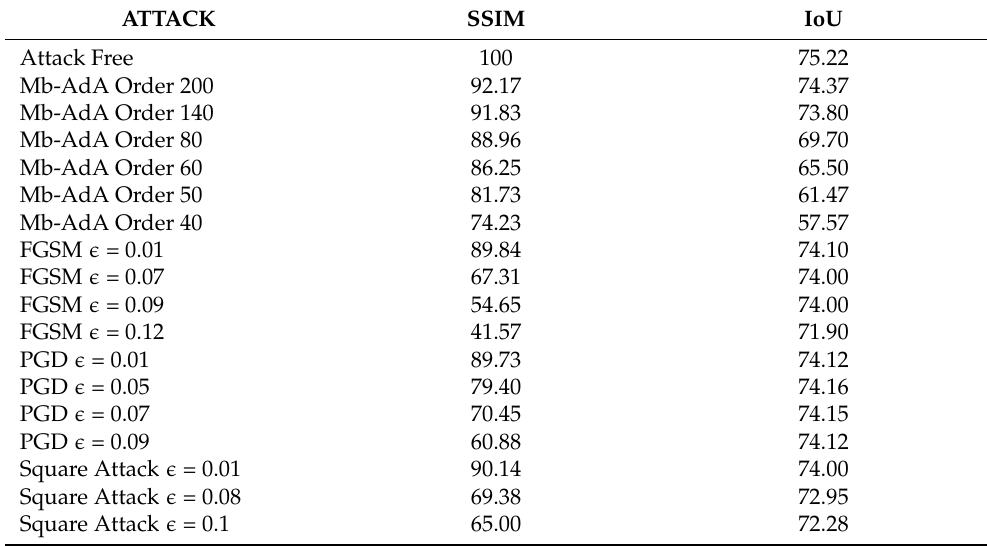
Table 1. Nuclei segmentation results under all attacks in terms of SSIM and IoU (in %).